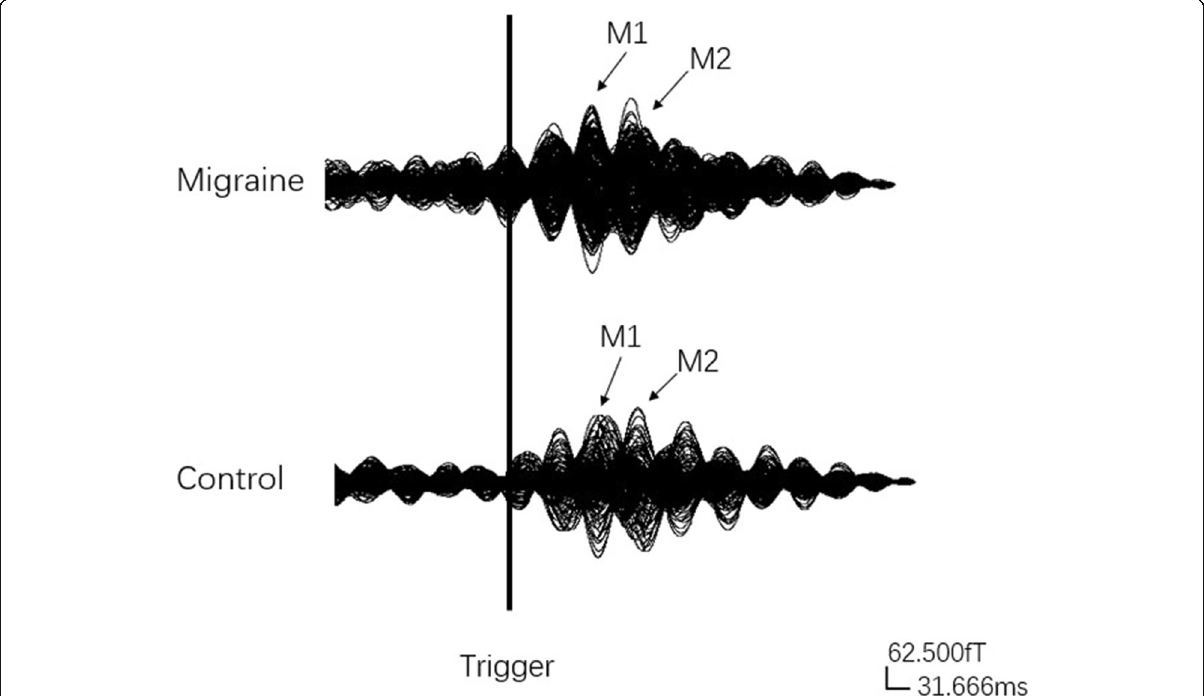
Fig. 2 Magnetoencephalography (MEG) waveforms, showing neuromagnetic activation upon exposure to emotional stimuli in a migraine subject and a healthy subject in the 8 – 12 Hz frequency range. “ M1 ” and “ M2 ” were the two main components evoked by human facial expressions. The “ Trigger ” indicates the start of emotional